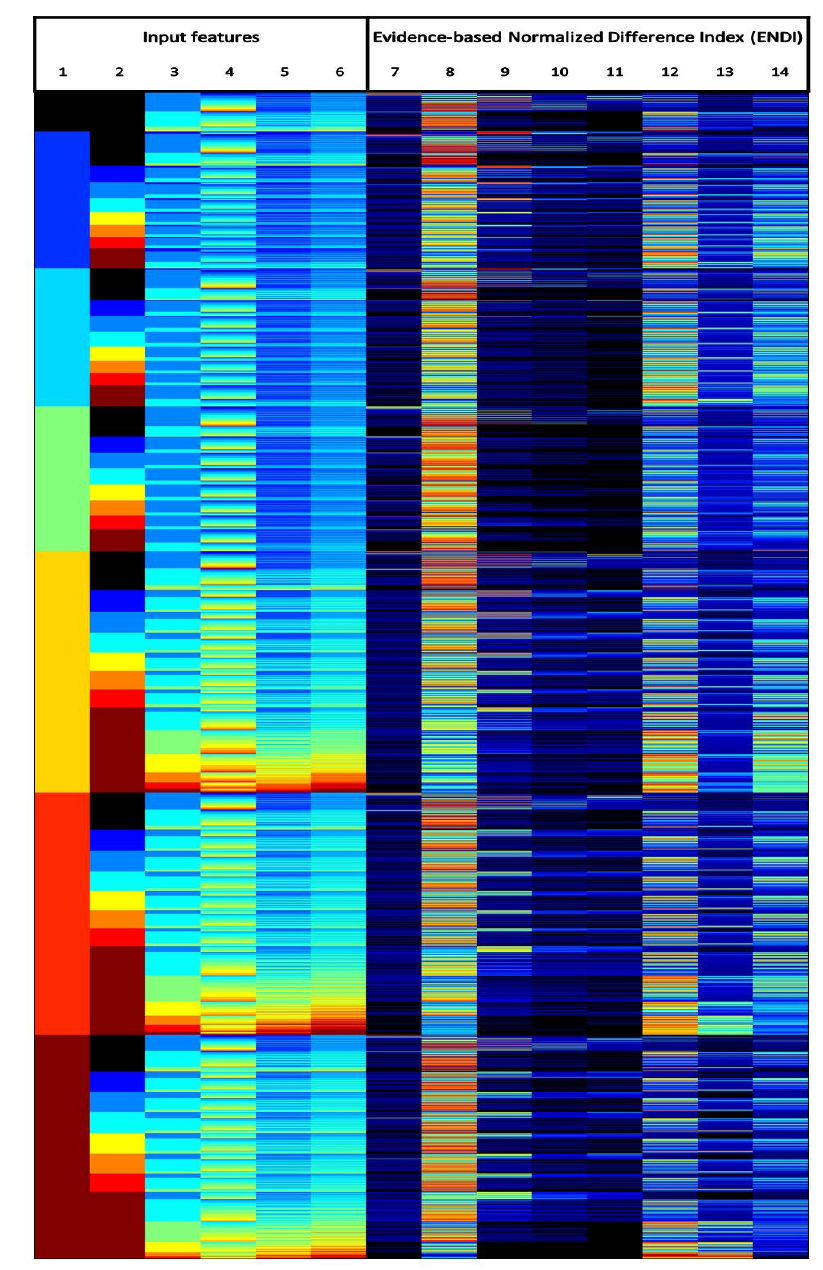
Figure 4. Sequences obtained using the Spot 5 data and the Corine Land Cover (CLC) reference. From left to right, the first six columns represent the quantized values of the input image features: (1) C , (2) S , (3) L , (4) G , (5) R and (6) NIR . The following columns show the Φ E values for eight CLC classes: water (7), agricultural (8), generic forest (9), broad-leaved forest cover (10), coniferous forest cover (11), generic urban (12), industrial areas (13) and residential areas